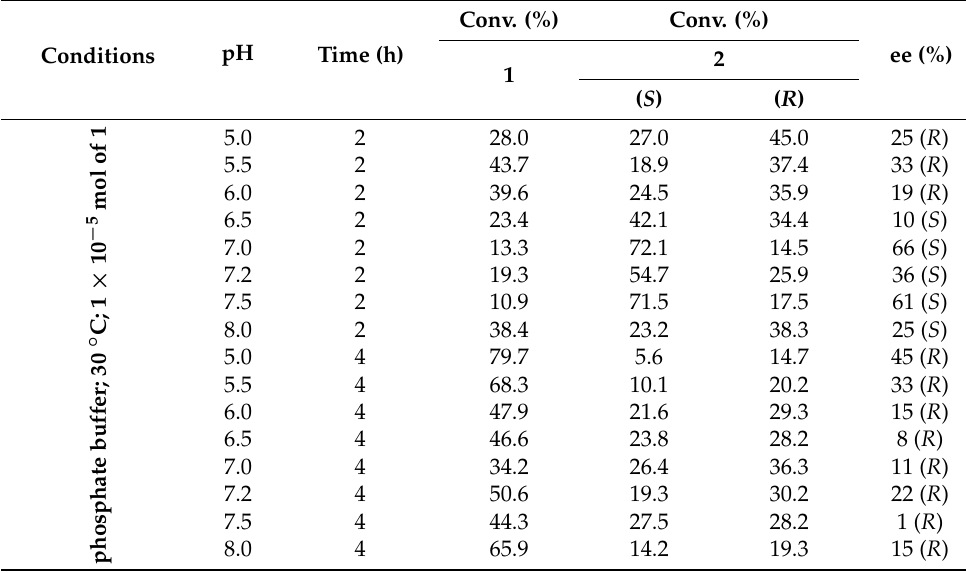
Table 6. Time Profile of Bioreduction of 1 Catalyzed by A. pullulans Strain DSM 14940 and DSM 14941 in Phosphate Buffer at Different pH Values. Conditions pH Time (h)